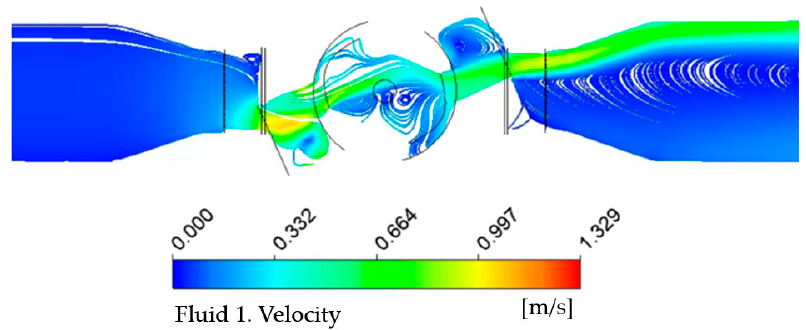
Figure 4. Streamlines at an opening rate of 20% for the cylinder-in-ball valve.